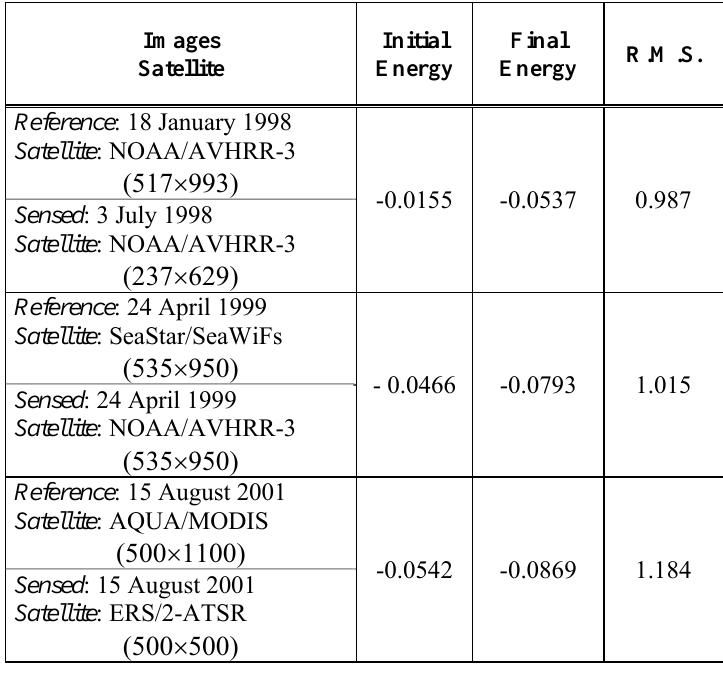
Table 2. Results of satellite image registration for three test cases.